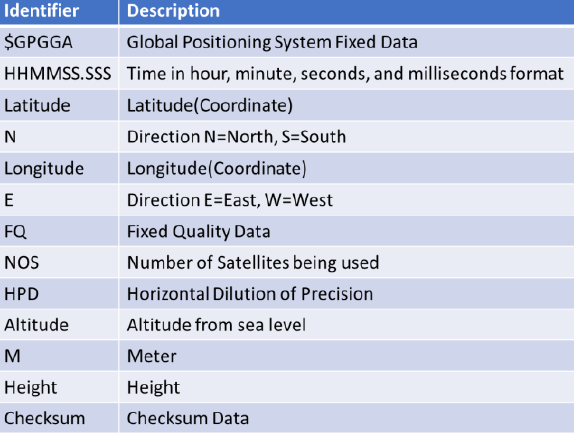
Figure 4 . $GPGGA Coordinate Data